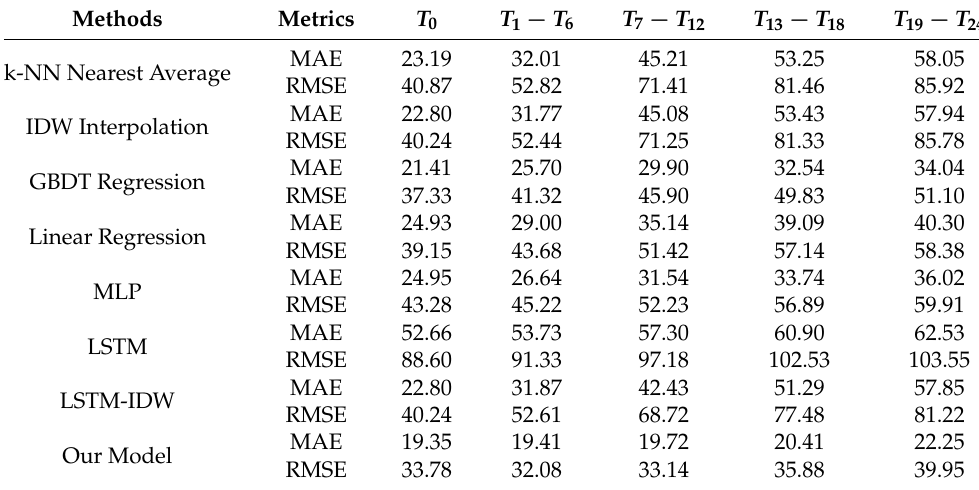
Table 1. Comparison between the proposed and the baseline models. The values in the table are the MAE and RMSE of AQI values.